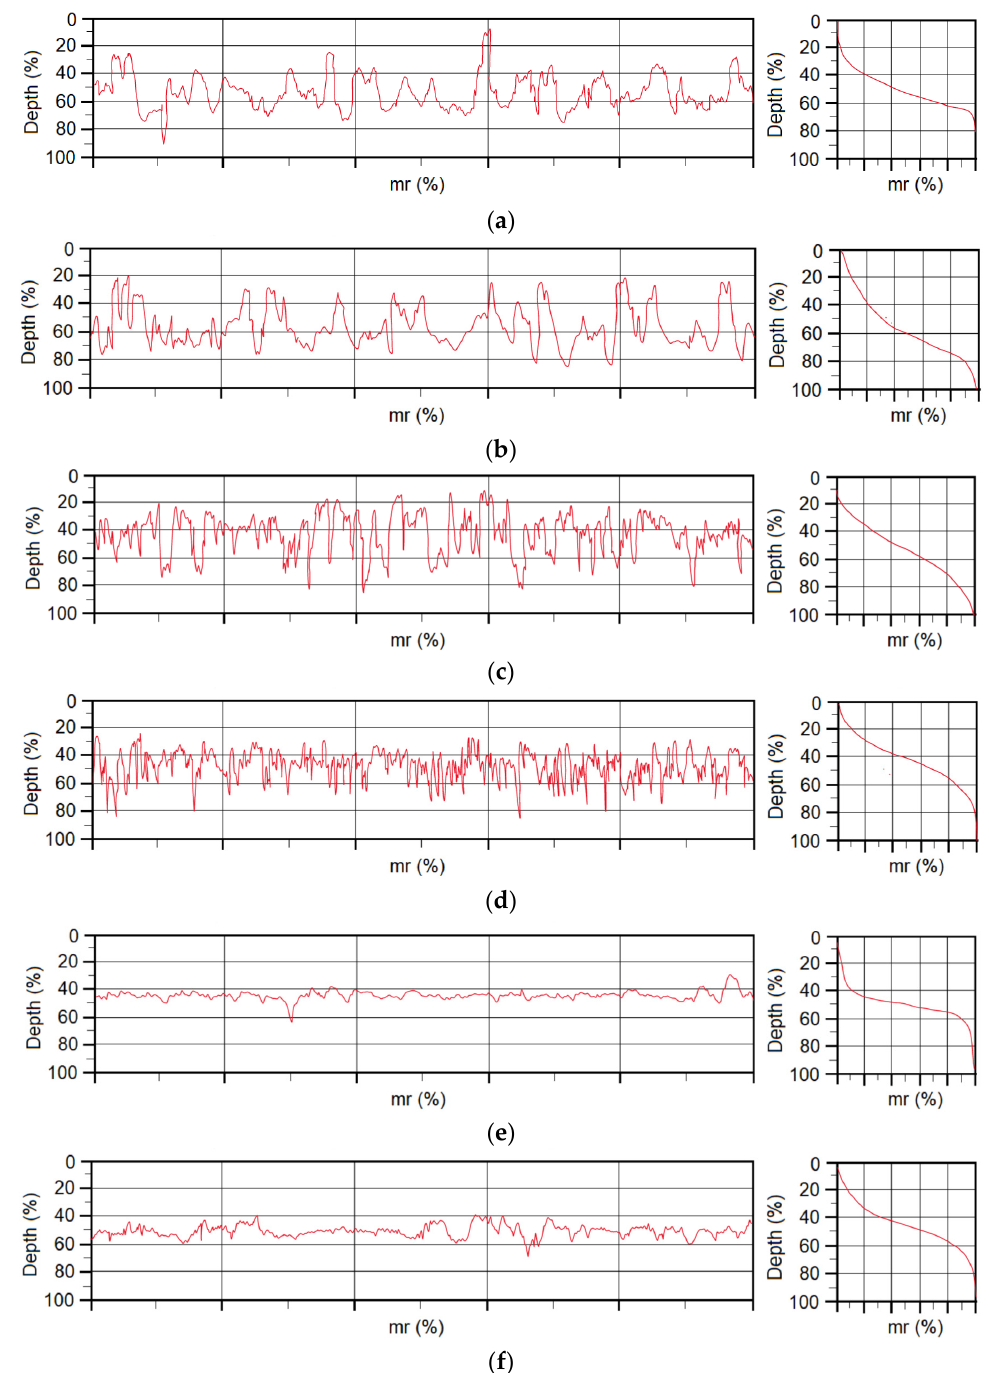
Figure 4. Profilograph of materials in initial state as well as treated with adhesion promoter: ( a ) DC initial surface, ( b ) DC + adhesion promoter, ( c ) TL initial surface, ( d ) TL + adhesion promoter, ( e ) Al initial surface and ( f ) Al + adhesion promoter.